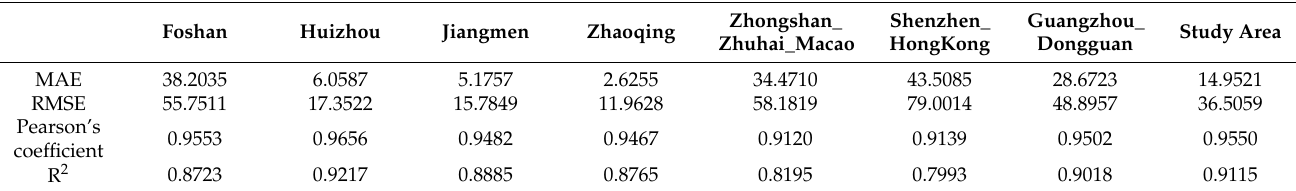
Table 1. The performance of GWR models for the seven zones, as well as for the entire study area. Foshan